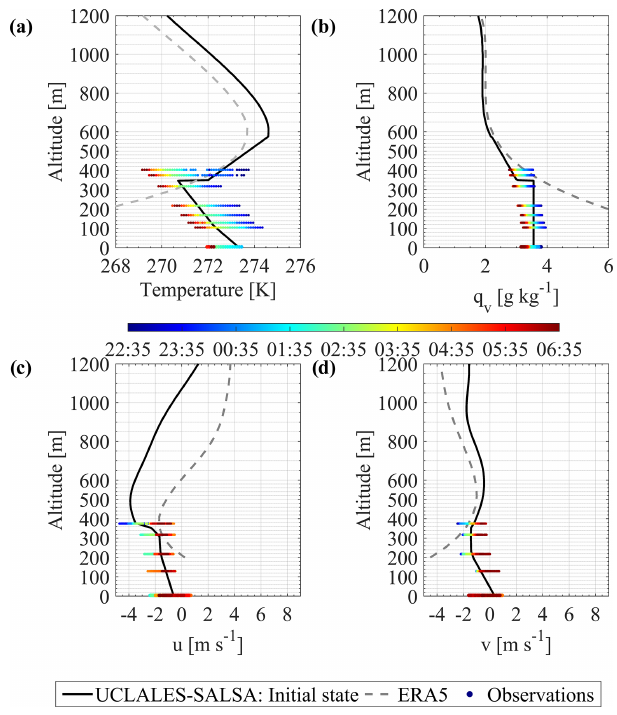
Figure 2. Vertical profiles used to initialize the simulation of case 2, nocturnal cloud event of 31 October 2020 starting at 00:30 (UTC + 2 : 00). (a) Potential temperature, (b) specific humidity, (c) u component, and (d) v component of the horizontal wind veloc- ity. Each panel also shows local surface observational data from the Savilahti station, local vertical profiles observed at the Vehmasmäki station, and reanalysed data from